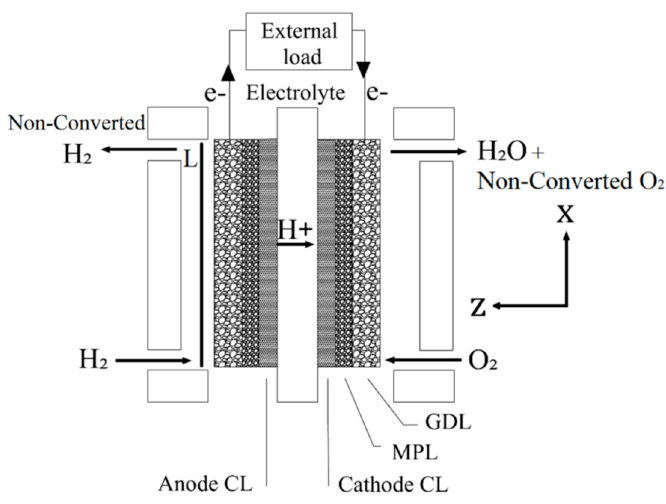
Figure 9. Schematic illustration of PEMFC operation principle. Reprinted from [121].